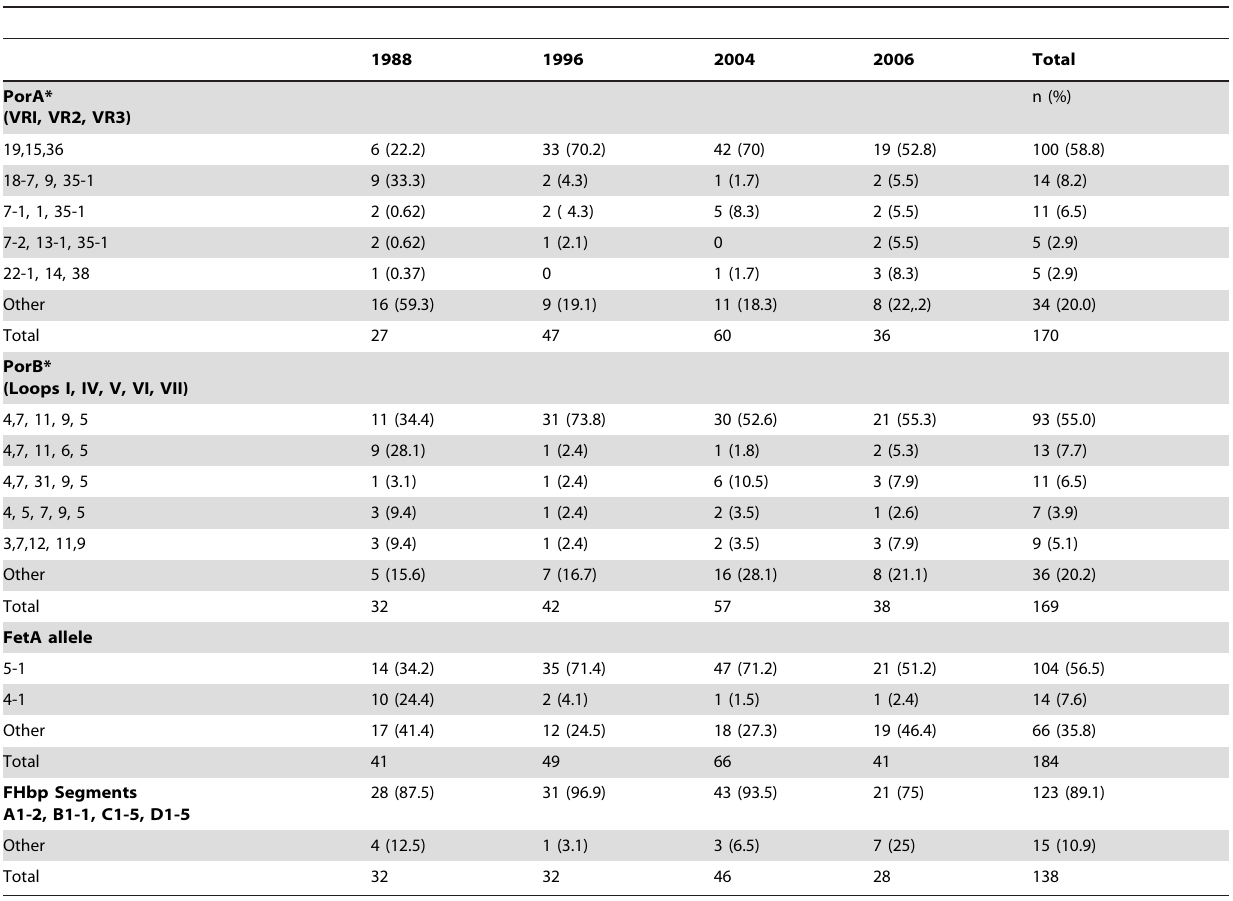
Table 2. Por A, Por B, FetA, FHbp by Year, Sao